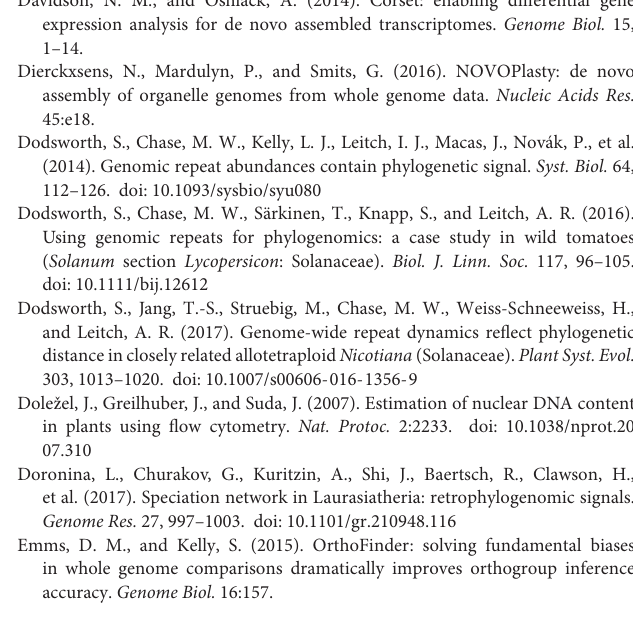
Supplementary Table 8 | Mixture modeling of synonymous divergence between Heliophila and Chamira species. Supplementary Table 9 | Summary of SNP frequency analysis based on transcriptome data. Supplementary Table 10 | Chloroplast genome assembly statistics of analyzed Heliophila and Chamira species. Supplementary Table 11 | Tandem repeats identified by RepeatExplorer2 and manual curation. Supplementary Table 12 | Pairwise sequence similarities between shared tandem repeats. Supplementary Figure 1 | BUSCO analysis of gene completeness. Supplementary Figure 2 | Fifty percent majority-rule consensus tree of the Bayesian inference of the ITS region. Supplementary Figure 3 | Time-calibrated plastome phylogeny of 59 Brassicaceae species. Supplementary Figure 4 | Dot-plot pairwise comparison of monomer consensus sequences of 16 identified tandem repeats shared among Heliophila species. Supplementary Figure 5 | Multiple and pairwise sequence alignments of 16 tandem repeats shared among 13 Heliophila species. Supplementary Figure 6 | Consensus network relationships of Heliophila species based on repeatome sequence similarities. Supplementary Figure 7 | Hierarchical clustering relationships of 15 Heliophila and C. circaeoides species produced from read abundance matrix produced by RepeatExplorer2